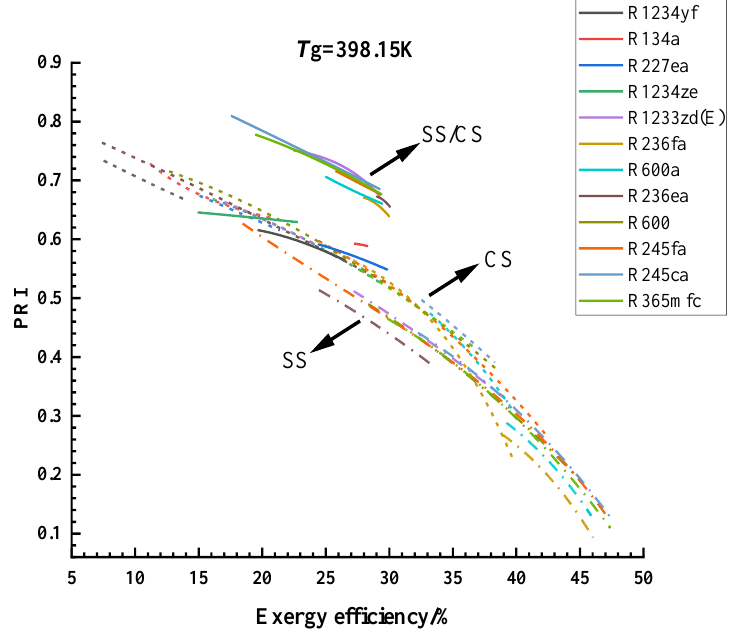
Figure 7. Optimized results under the heat source temperature of 398.15 K.